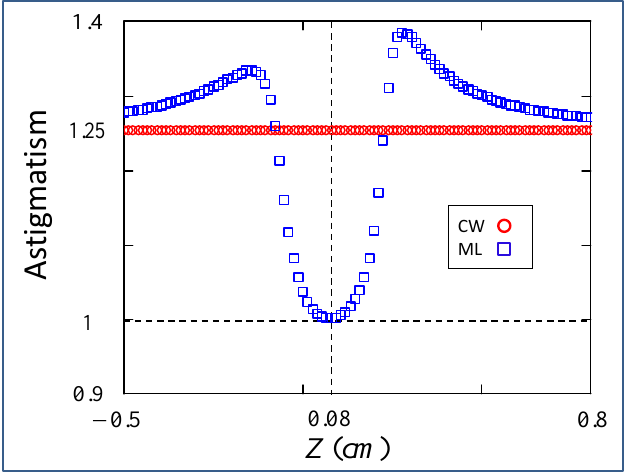
Figure 8. CW and ML astigmatism (defined as w a function of the crystal position for hard aperture mode-locking at δ (cid:46) δ astigmatism of ≈ 1 . 24 is pre-introduced into the CW mode, allowing for the stronger Kerr effect in the sagittal plane to “catch up” with the weaker tangential plane, resulting in the astigmatically-compensated ML mode at Z ≈ 0 . 08 for a specific value of K = 0 . 1